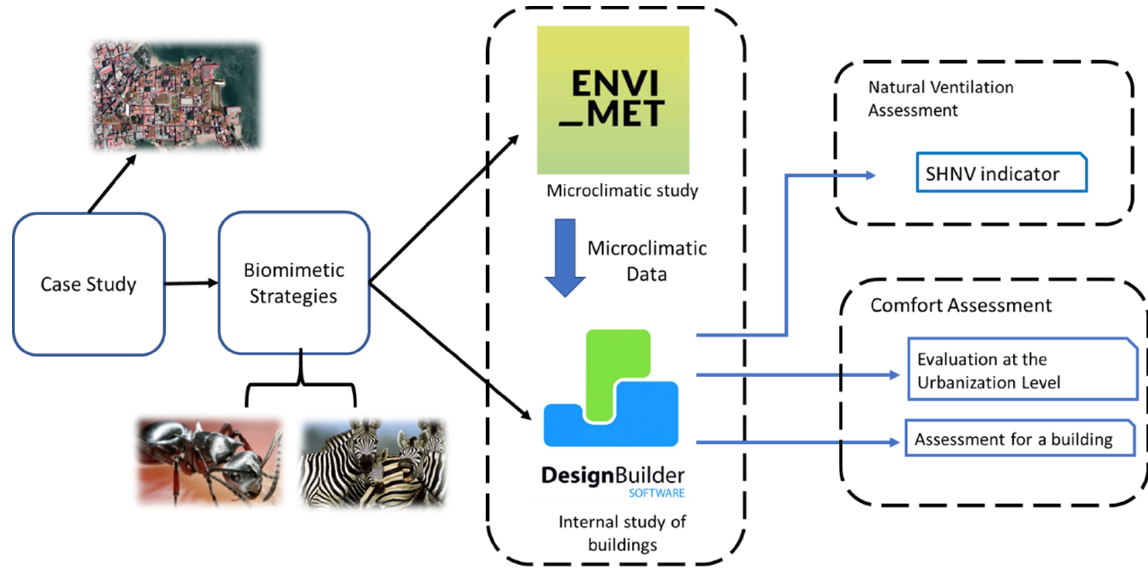
Figure 1. Proposed methodology for the development of the research. Own elaboration.